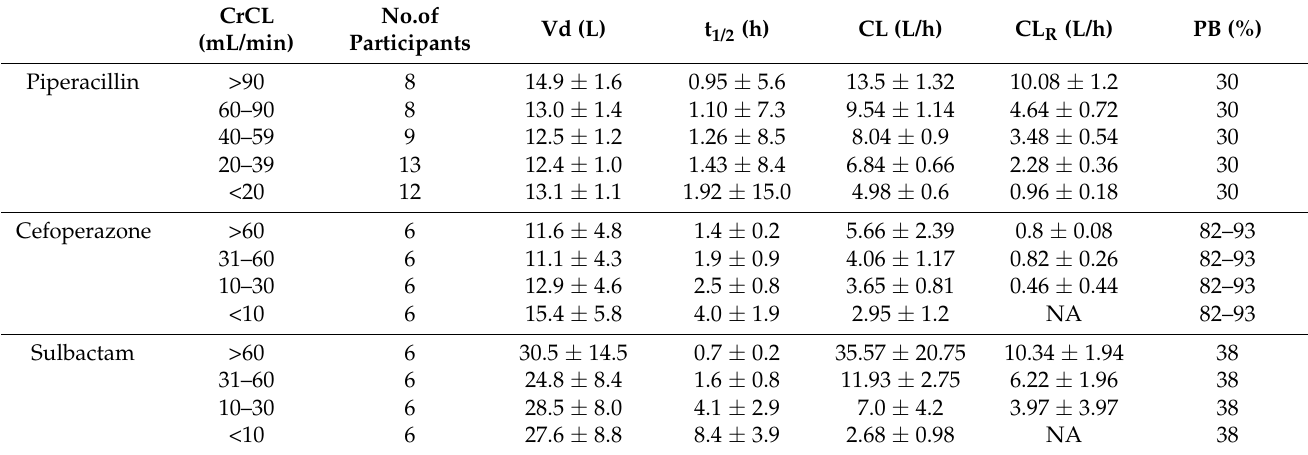
Table 3. Pharmacokinetic parameters used for the Monte Carlo